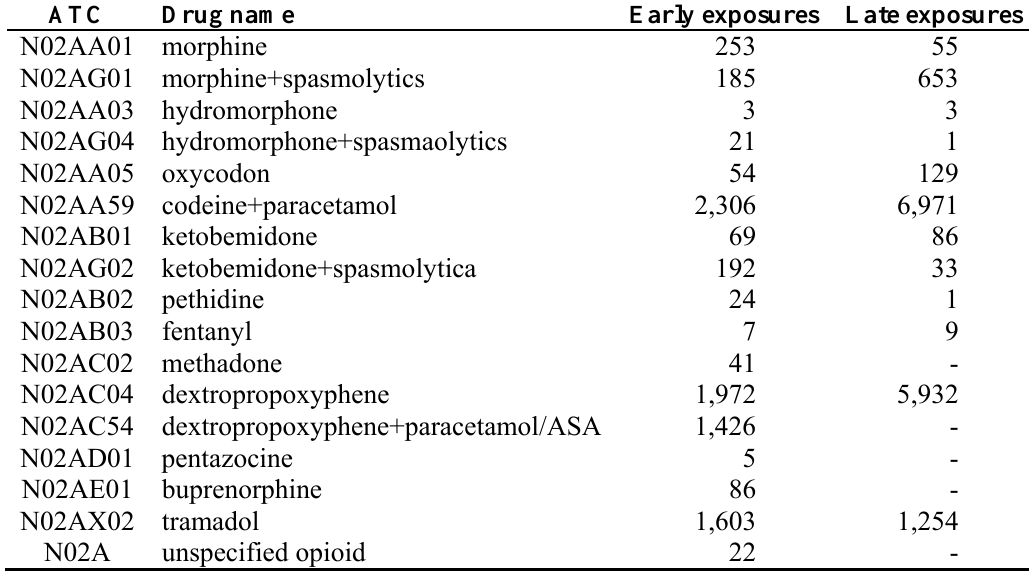
Table 7. Number of children exposed in early pregnancy for opioids and number of children born to women who filled prescriptions during the 2nd or 3rd trimester (late exposures).